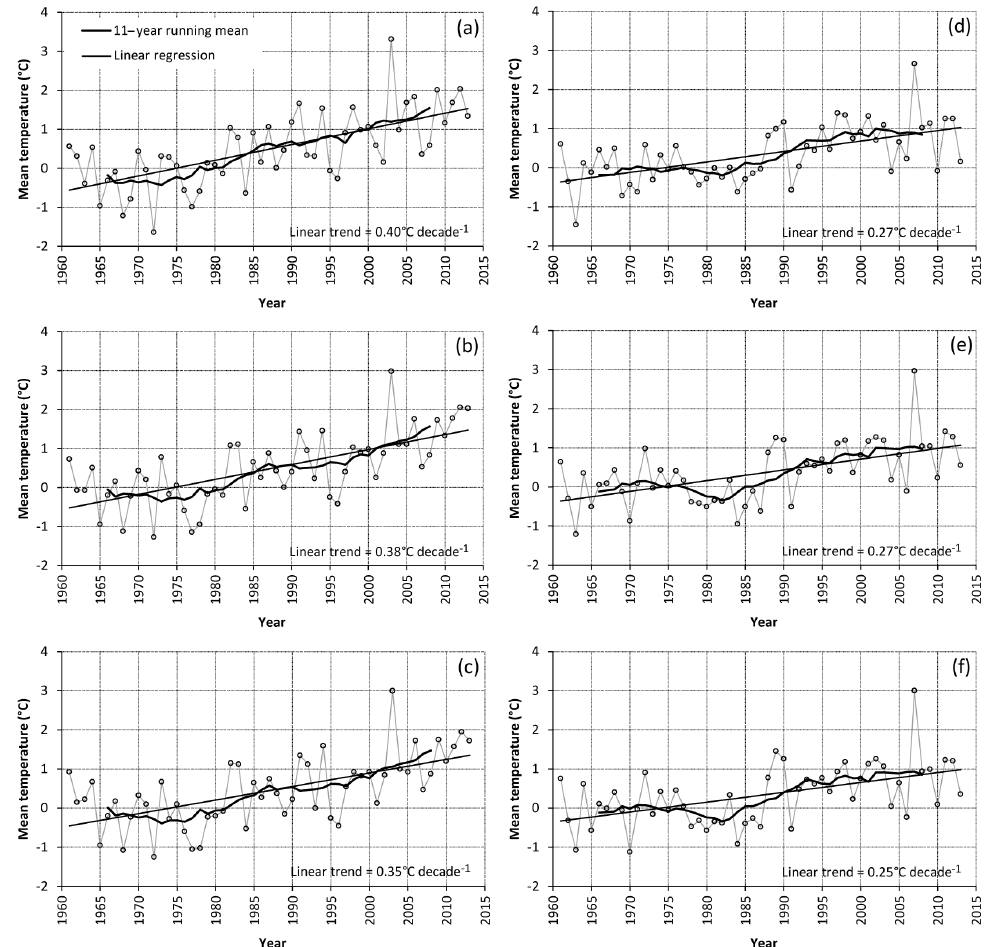
Figure 5. Left column: mean ablation season (Jun–Sep) air temperature anomalies in (a) Gran Paradiso, (b) Ortles-Cevedale and (c) Val Ridanna. Right column: mean accumulation season (Oct–May) air temperature anomalies in (d) Gran Paradiso, (e) Ortles-Cevedale and (f) Val Ridanna. Reference period: 1961–1990. All linear trends are significant at the 0.001 level.